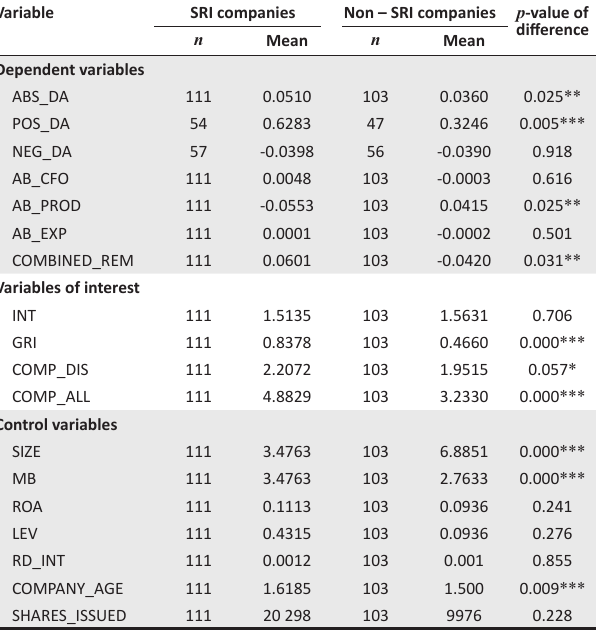
TABLE 3: Descriptive statistics by socially responsible investment versus non- socially responsible investment companies.